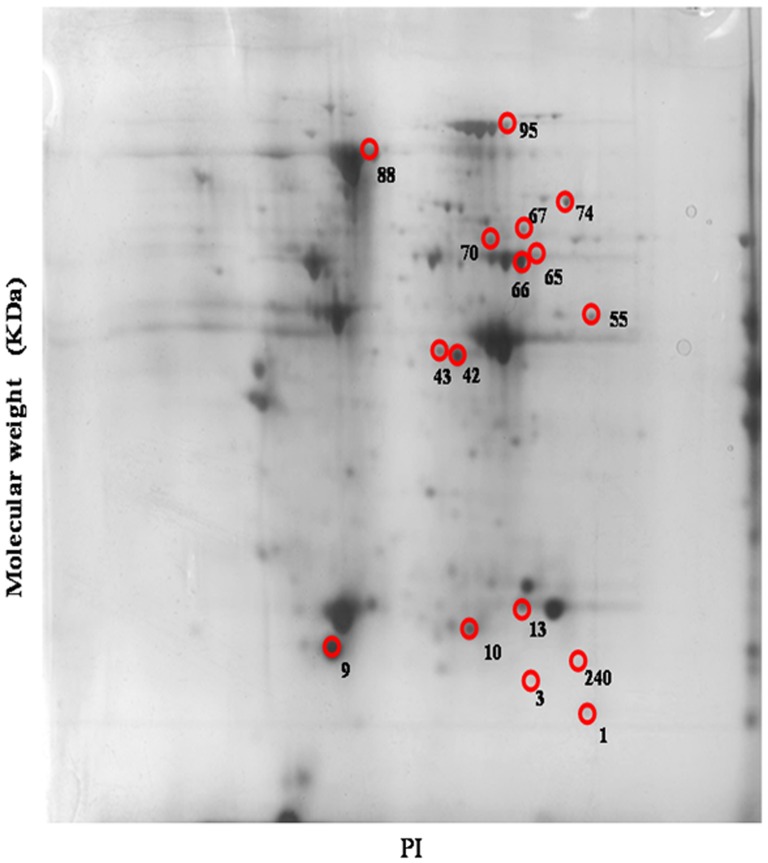
Protein analysis by 2D-gel electrophoresis.Sixteen proteins in the cervical muscle of day-1 chicks were significantly altered by VPA (60 µM) treatment. Six replicates were carried out to assure the results.